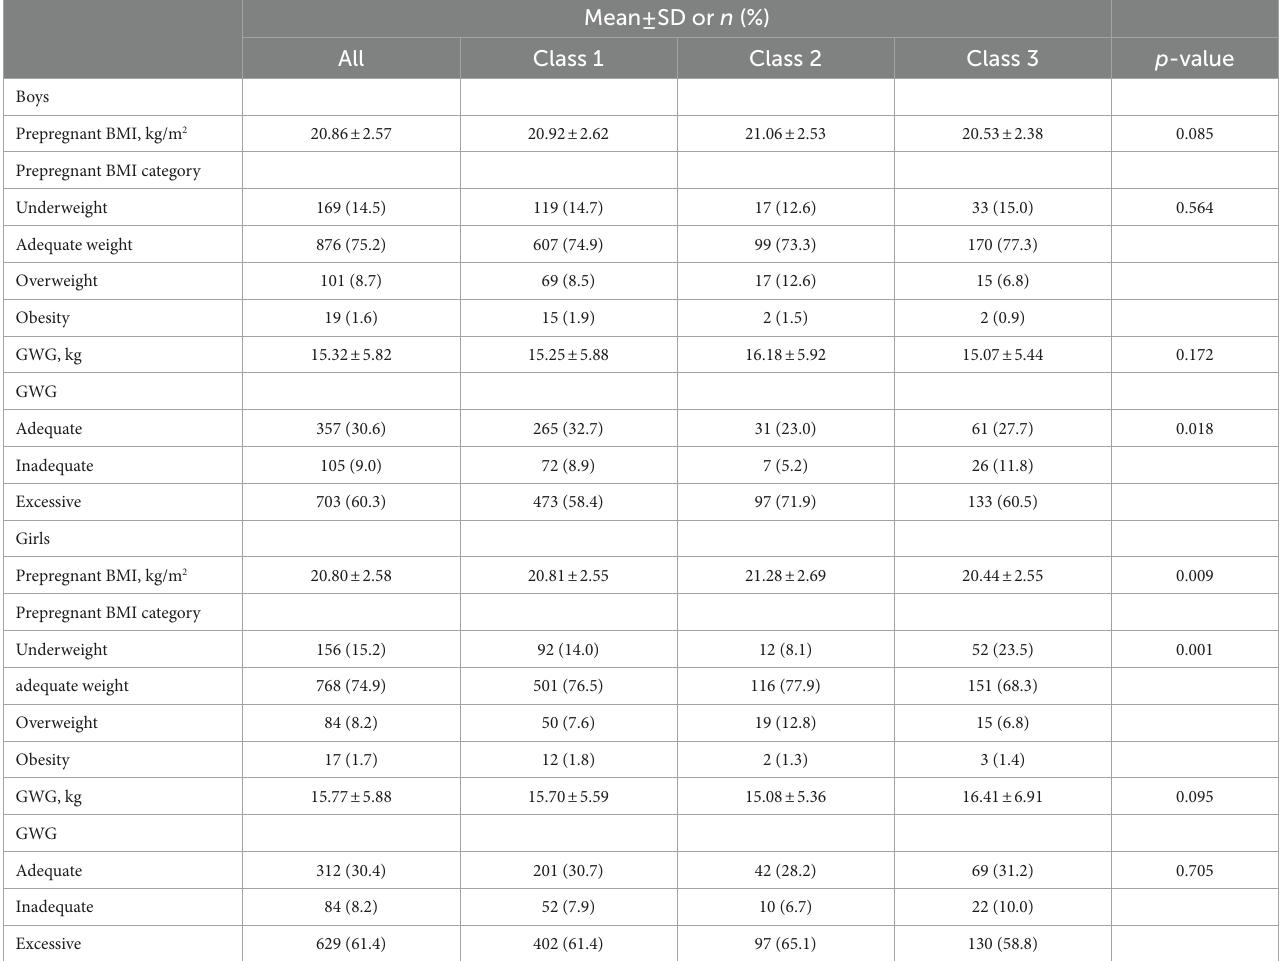
TABLE 2 Distribution of prepregnant BMI and GWG overall and according to child BMI-z growth trajectory classes stratified for sex. Mean ± SD or n (%) All Class 1 Class 2 Class 3 p -value